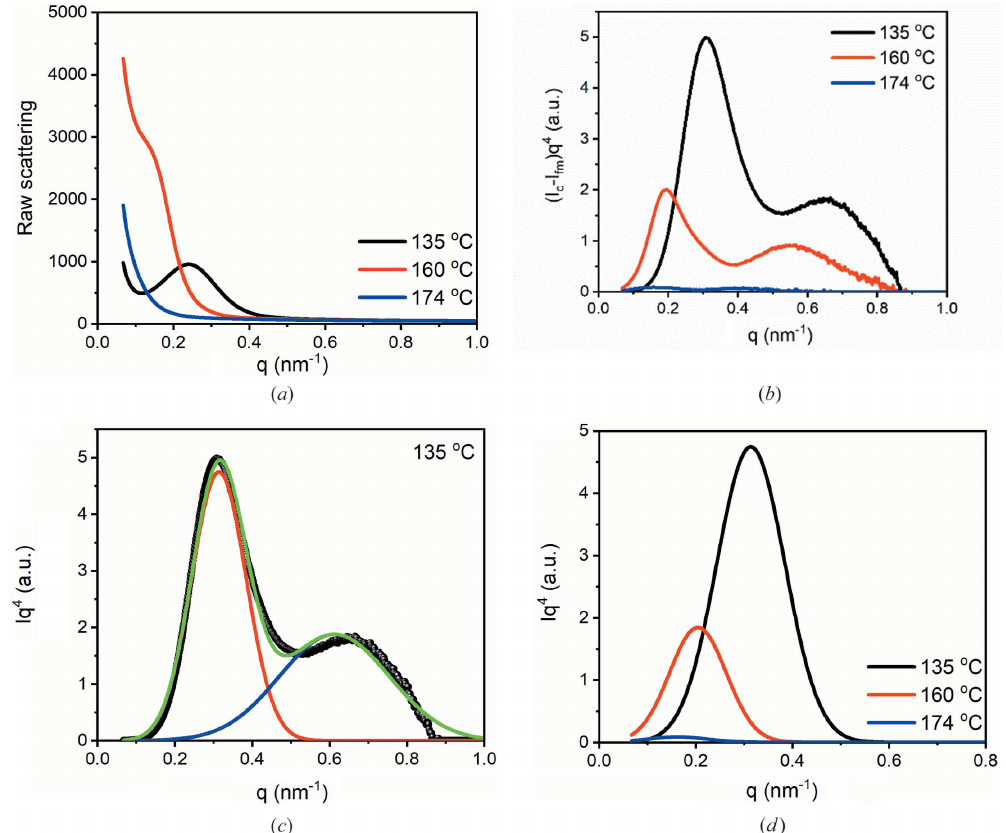
Figure 8 ( a ) Raw scattering at 135, 160 and 174 (cid:3) C. ( b ) The plots of Iq 4 at 135, 160 and 174 (cid:3) C. ( c ) Multi-peak fitting for Iq 4 at 135 (cid:3) C. ( d ) Long-period peaks at 135, 160 and 174 (cid:3)